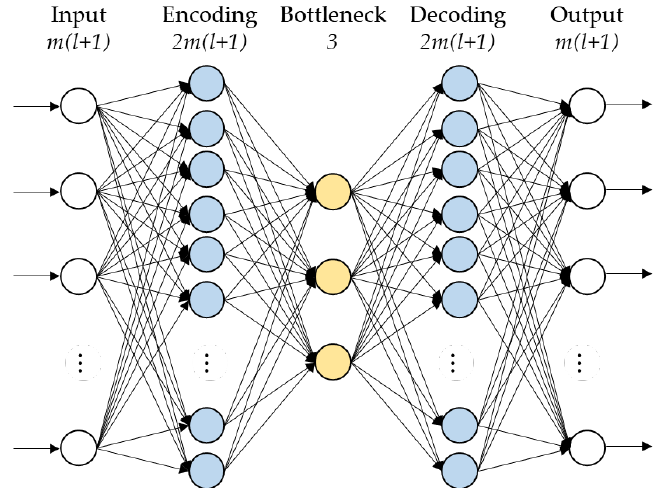
Figure 10. Illustration of a lagged AE network architecture. A lagged input, with m ( l + 1 ) variables, is projected to a high dimensional encoding layer. The hidden layer extracts representative features from this encoding layer, yielding the nonlinear AE subspace (3 features in this example). The decoding and output layers are used to reconstruct the lagged input from the subspace.